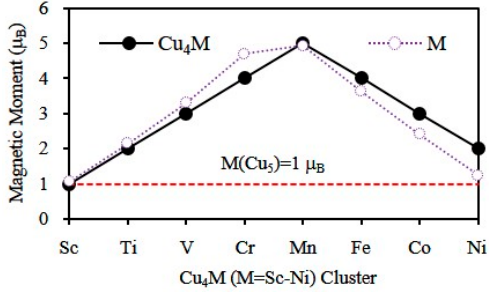
Figure 8. Total magnetic moment of the ground state Cu 4 M (M = Sc-Cu) clusters and local magnetic